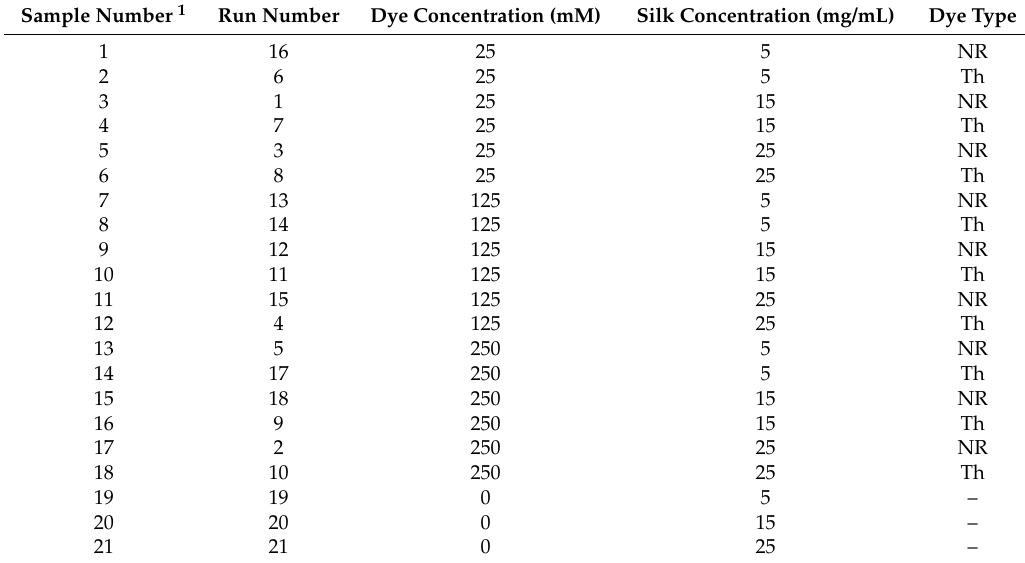
Table 1. Factorial design samples.